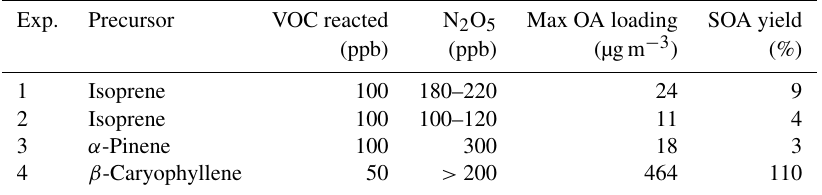
Table 1. List of experiments and summary of experimental conditions.